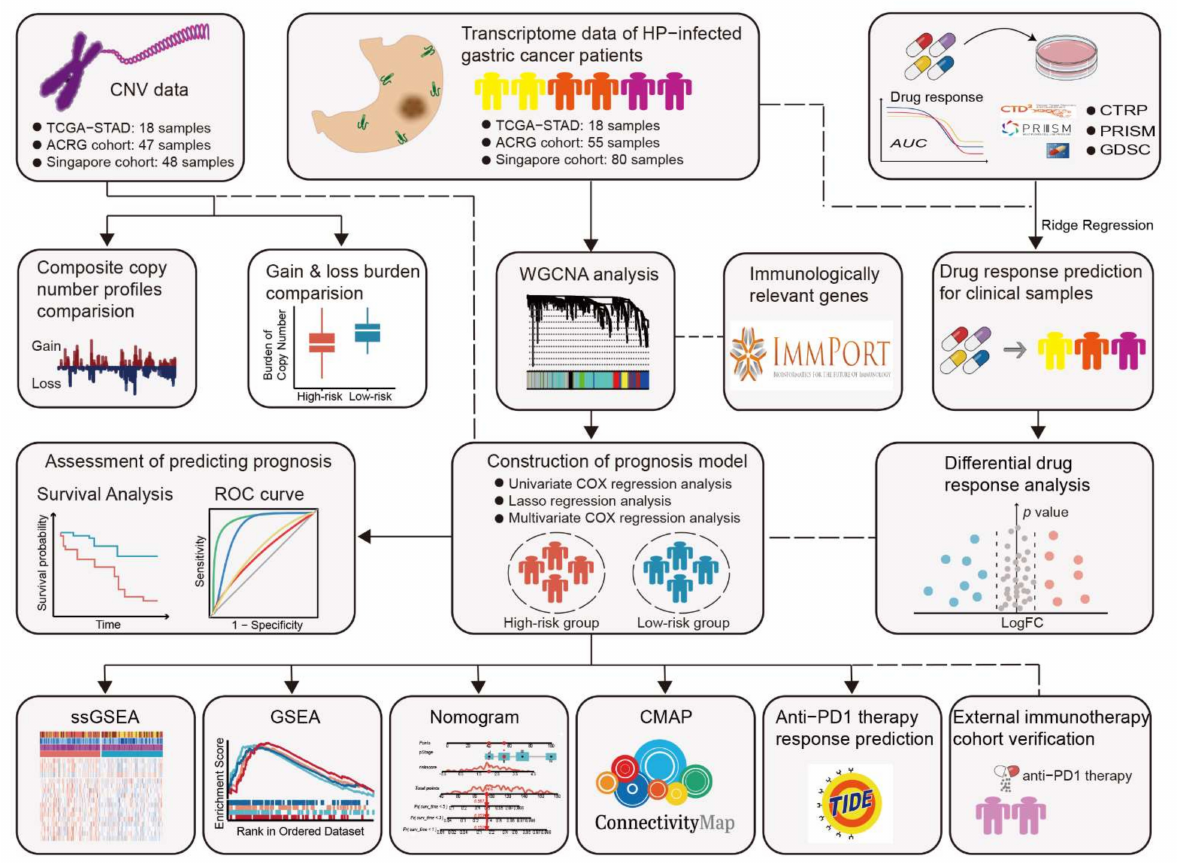
Figure 1. Flowchart for this